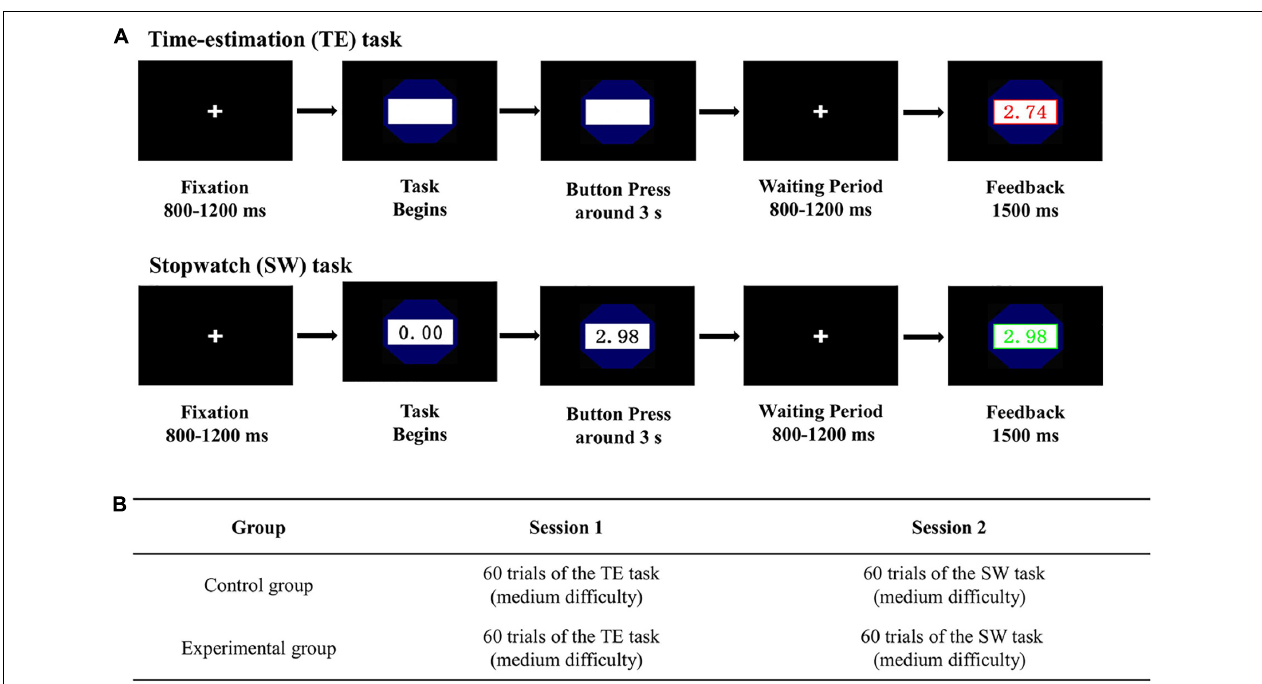
FIGURE 1 | Demonstration of the experimental paradigm. (A) TE and SW tasks. (B) The experimental